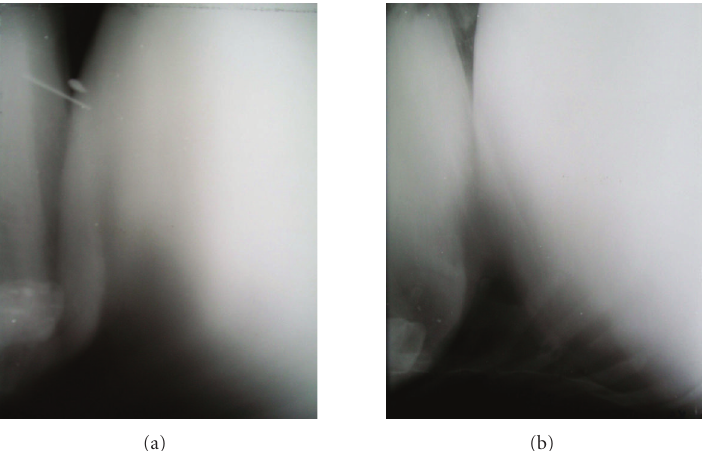
Figure 6: Lateral radiographs of reticulum showing indistinct line of diaphragm. Diaphragmatic hernia is not apparent on radiographs.